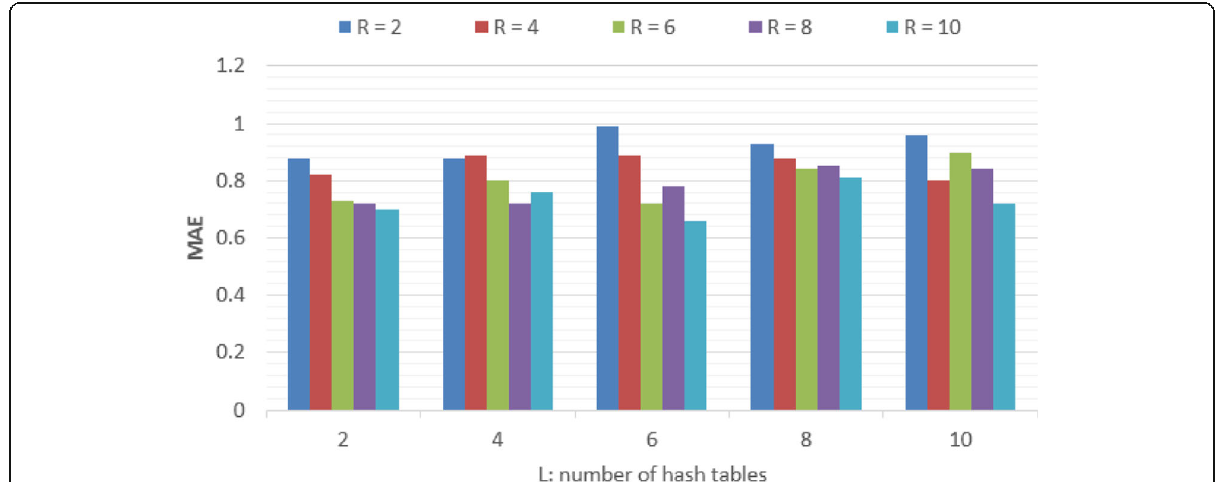
Fig. 6 MAE w.r.t. L - R